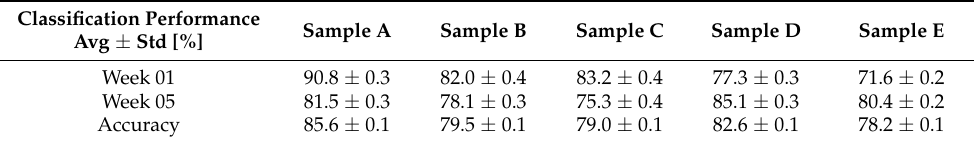
Table 3. Binary classification of cells from week 1 and 5 using logistic regression trained and tested with cells from the same sample.